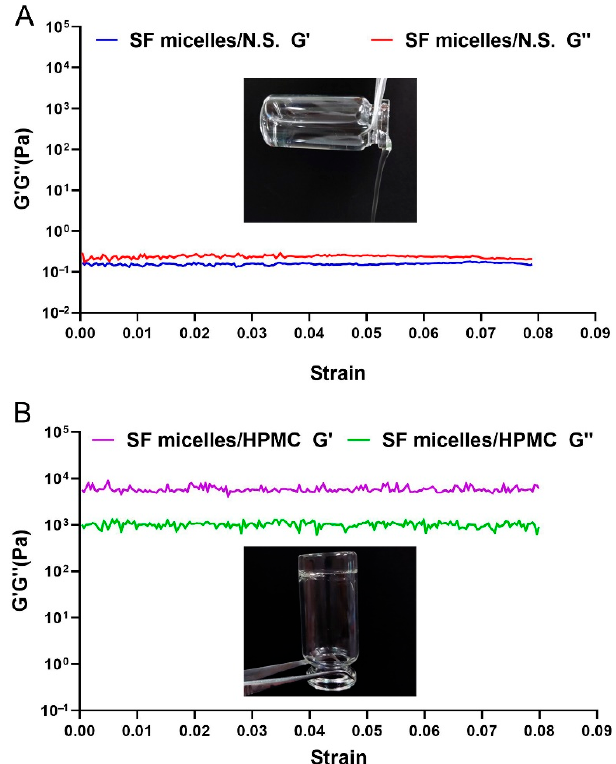
Figure 5. Frequency spectra of the elastic (G ′ ) and viscous moduli (G ″ ) of ( A ) SF micelles dispersed in N.S. and ( B ) HPMC.